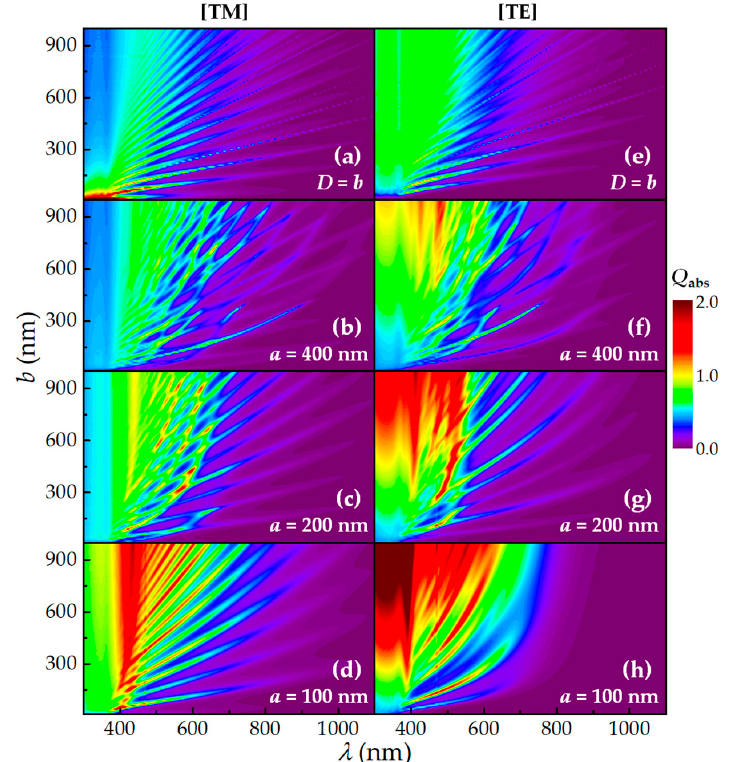
Figure 6. Q abs versus b and λ for the CNWs and ENWs: ( a – d ) for TM and ( e – h ) for TE light illumination (with an identical color scale); ( a , e ) for the CNW with D = b ; ( b , f , c , g , d , h ) for the ENWs with a = 400, 200 and 100 nm, respectively.